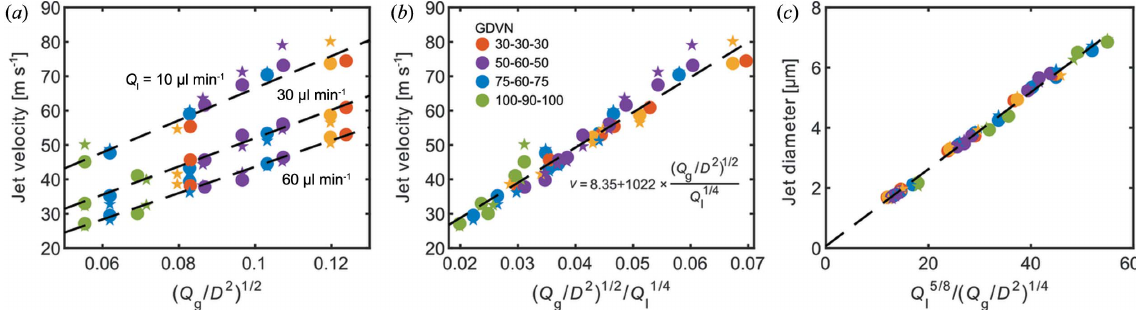
Figure 4 ( a , b ) Plots of the experimentally determined jet velocities for the four different GDVN types as a function of applied liquid and gas flow rates. Circles represent data from the jet explosion method, while stars denote velocities from the droplet PIV method. In panel ( b ) the broken line describes the jet velocity prediction formula v jet = a + b (cid:6) ( Q g / D g2 ) 1/2 /( Q l ) 1/4 , where the constants have the numerical values a = 8.35 and b = 1022 if Q g is given in mg min (cid:4) 1 , D g in m m, Q l in m l min (cid:4) 1 and v jet in m s (cid:4) 1 . ( c ) The corresponding jet diameters are calculated via d jet = [4 Q l /( (cid:3) v )] 1/2